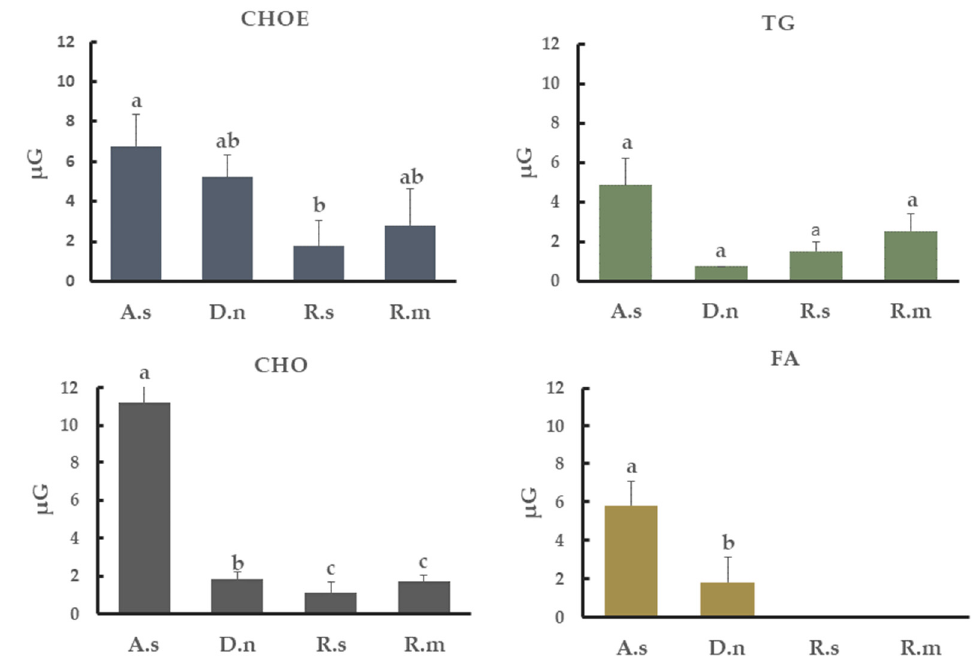
Figure 5. Concentration of cholesterol-ester (CHOE), triacylglycerol (TG), cholesterol (CHO) and fatty acid (FA) in the cuticle of engorged females of Amblyomma sculptum (A.s), Dermacentor nitens (D.n), Rhipicephalus sanguineus s.l. (R.s) or Rhipicephalus microplus (R.m) obtained by densitometry analysis. Bars with the same letter do not differ significantly ( p > 0.05) by the Kruskal–Wallis test followed by the adjusted Student’s t -test. Each bar represents the mean of three independent exper- iments.